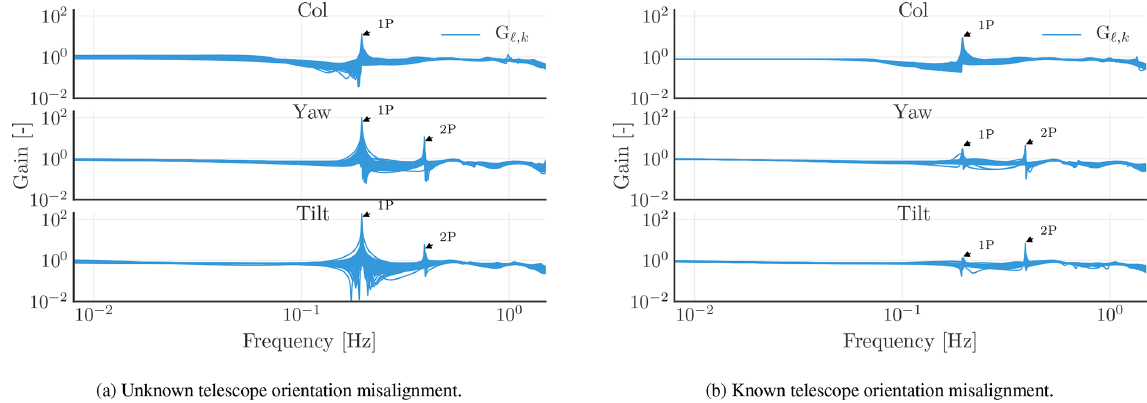
Figure 17. Identified transfer functions ( G (cid:96),k ) from the blade effective wind speeds ( u beff ,k ) to the corrected lidar-based inflow wind speeds ( u cor ,k ) for the discrete set of sampled telescope parameters with unknown and known telescope orientation misalignment, where k ∈ { col, yaw, tilt }